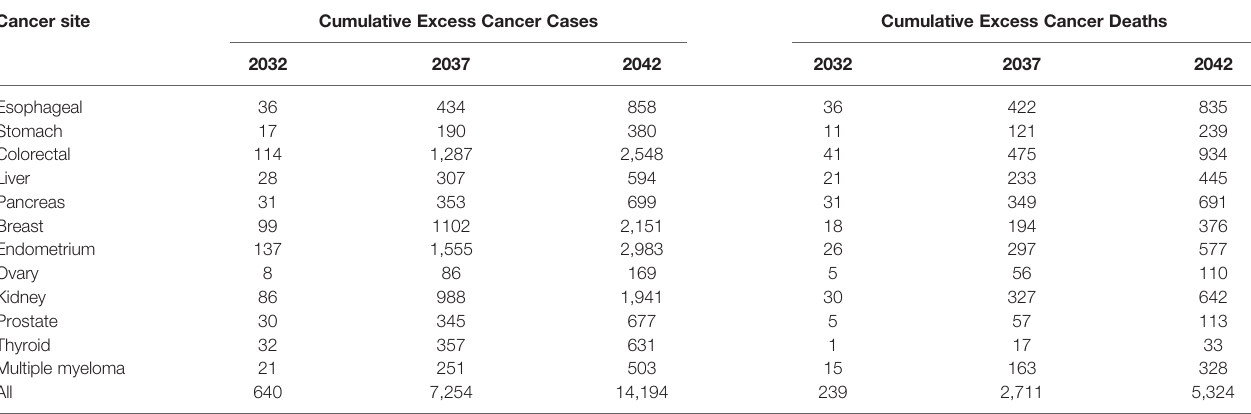
TABLE 2 | Projected cumulative excess cancer incidence and mortality due to body weight change during the COVID-19 pandemic in 2020/21 assuming 42.3% of population gained weight and 15.6% lost